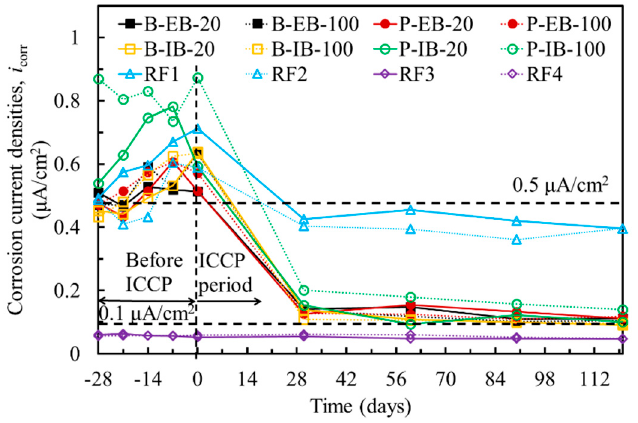
Figure 5. Corrosion current densities of the steel rebars and steel plate before and after EC tests.